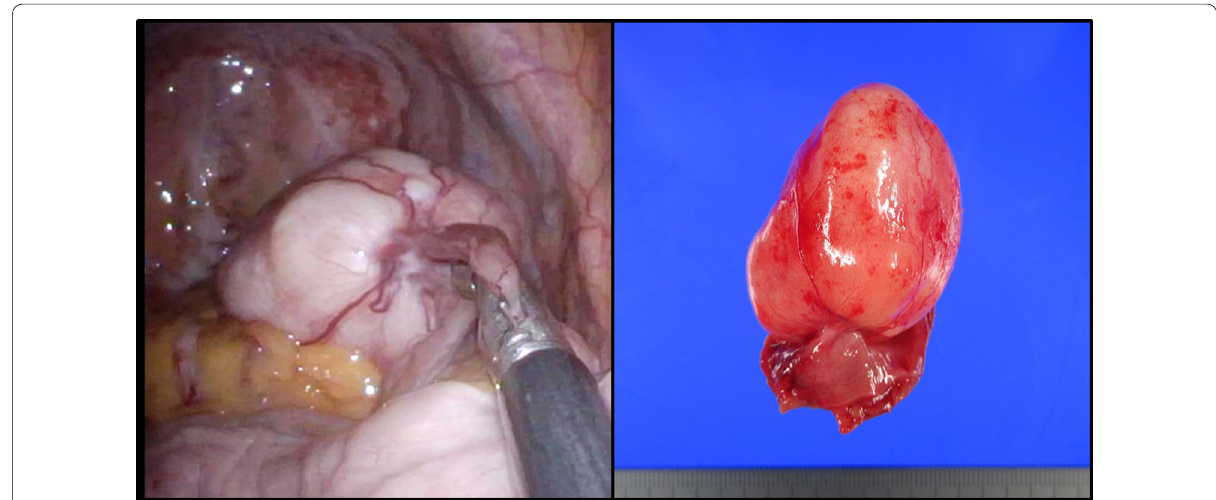
Fig. 2 Intraoperative findings. A white-colored tumor was found in the ileum. The tumor was pedunculated and located on the antimesenteric side